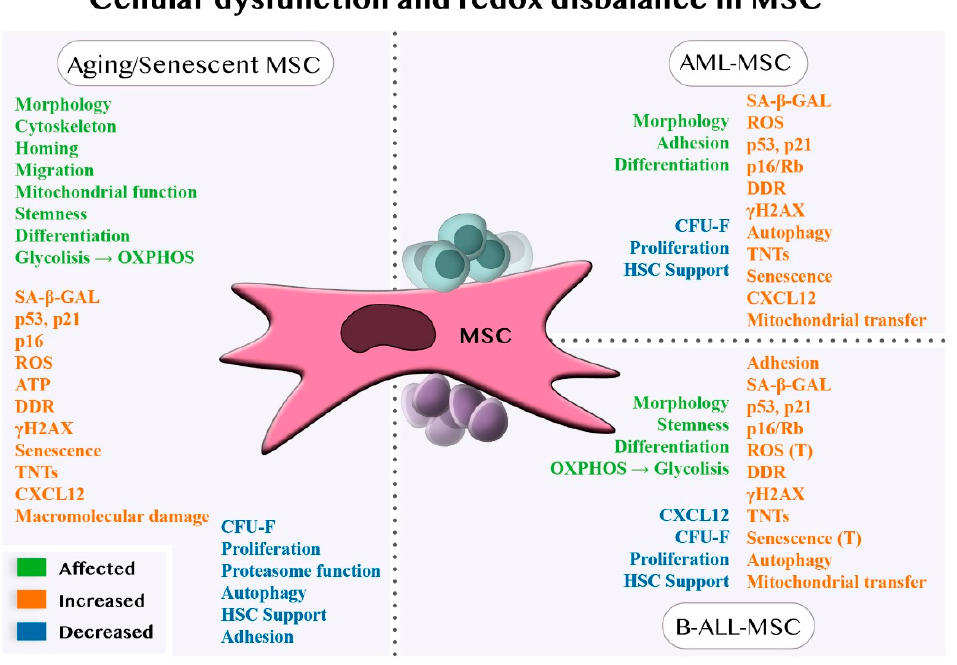
Figure 1. Cellular changes in MSCs induced by aging/senescence and hematological malignancies (AML or B-ALL). MSCs subjected to a physiological aging process or exposed to a pathological envi- ronment in the presence of leukemic blasts exhibit common characteristics. MSCs enter senescence, overexpressing molecular markers related to DNA damage and cell-cycle arrest. At the same time, they showed impairment in functions associated with HSC support, the maintenance of the redox balance, and homeostasis. In B-ALL, some of these characteristics seem to be transient (T). 4.3. Genetic, Epigenetic and Gene Expression Alterations of MSCs in Aging and Senescence Heterochromatin disorganization is considered a driver of MSC senescence in aging and disease [182,183]. Cellular models of aging display enlarged nuclei, signs of nuclear DNA decondensation, and heterochromatin loss [184]. Interestingly, lamin B1 downreg- ulation has been shown to be a key trigger of global and local chromatin reorganization during cell senescence, having an impact on gene expression and aging [185]. Within the local heterochromatin reorganization, it is very likely that those driving the expression of SASP genes (key effectors of the senescence program) must be